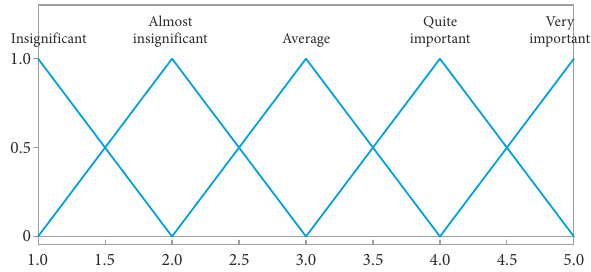
Figure 9. Linguistic terms of the input variable x 2 (own study)